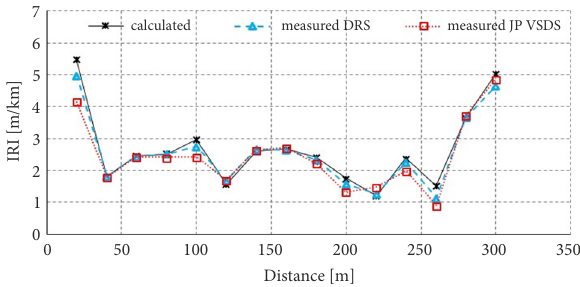
Figure 12. The comparison of calculated IRI values and IRI values measured by designed devices JP VSDS and DRS